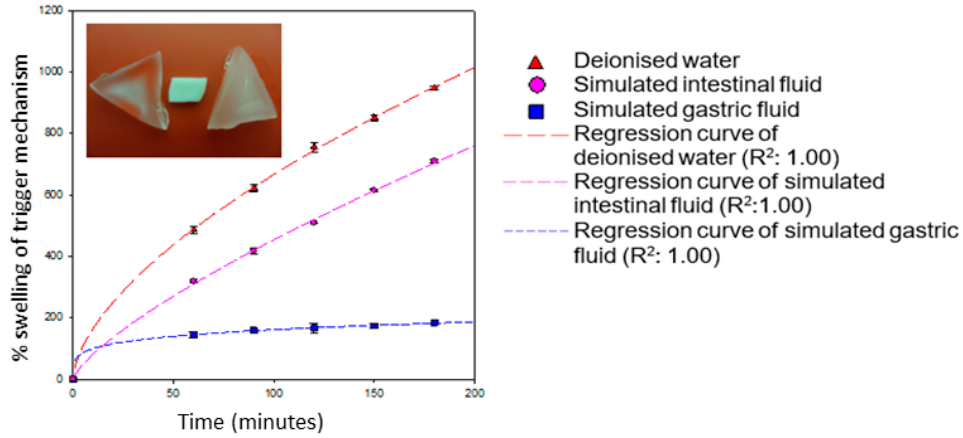
Figure 3. Swelling studies of the pH-responsive hydrogel in the respective solutions of deionized water (pH 7.0); simulated gastric fluid (pH 1.2) and simulated intestinal fluid (pH 6.8), with respect to percentage of swelling and time in minutes. Regression curves where fitted onto each respective scatter plot with an R 2 value of 1.00.